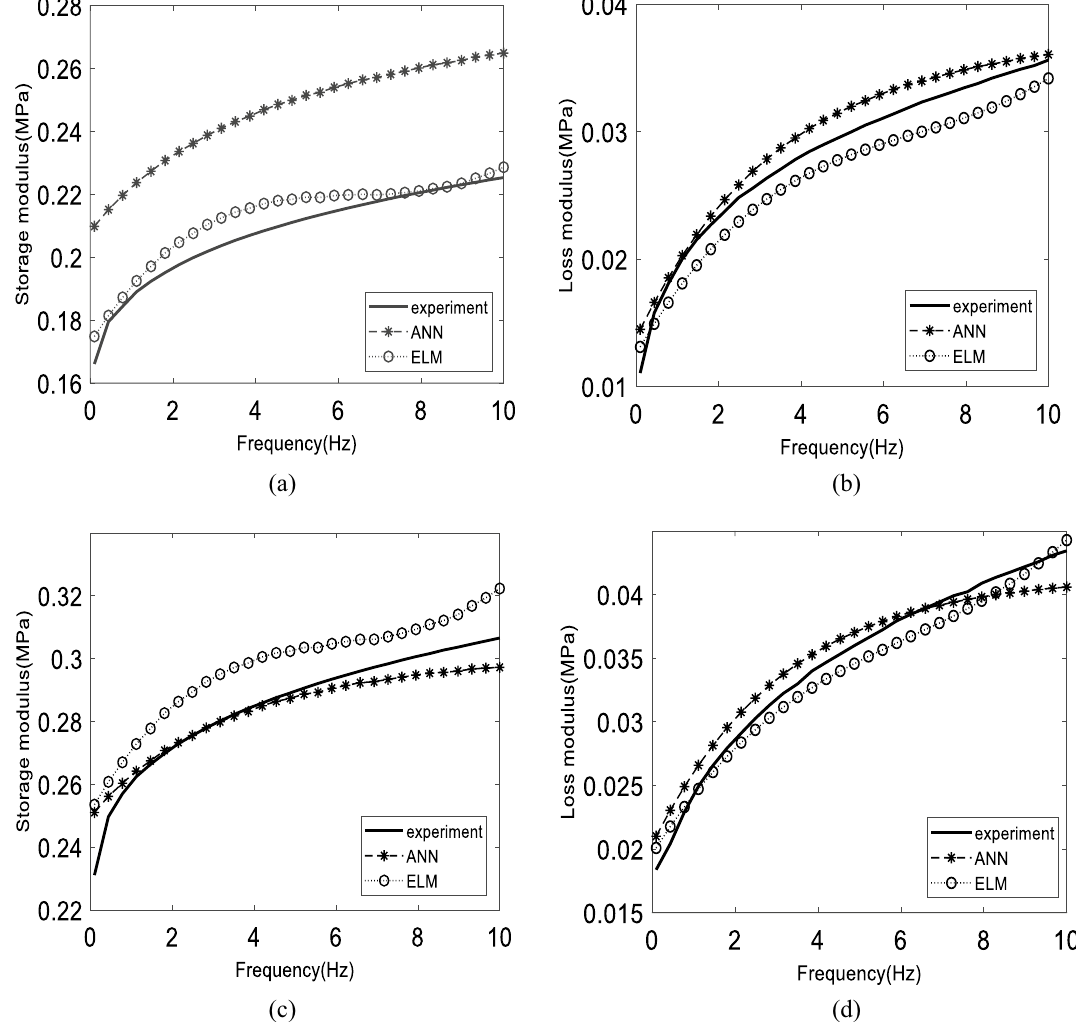
Figure 6. The comparison of dynamic moduli between experiment, ELM, and ANN model for Ts3 data set at 0.37 T, 50% of CIP: ( a ), ( b ) for isotropic distribution and ( c ), ( d ) for anisotropic distribution.